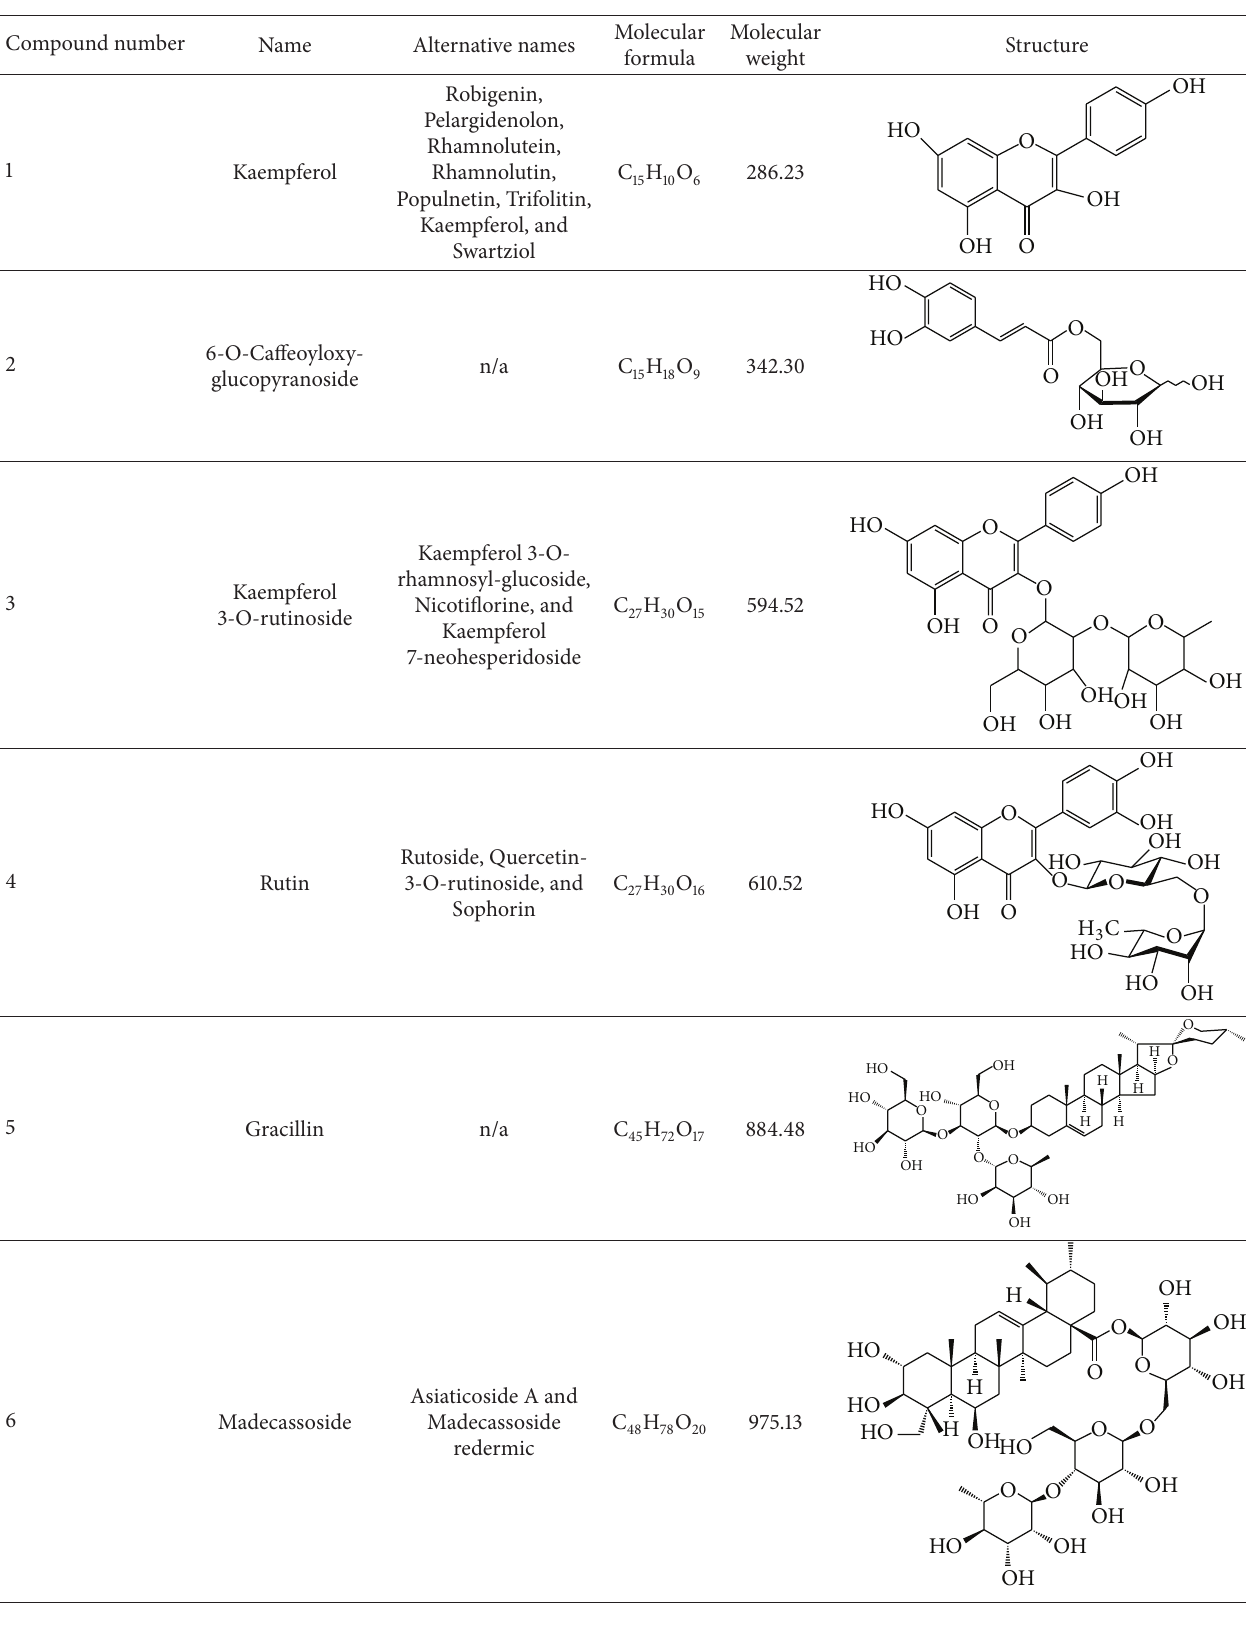
Table 2: Information of Sanjin Tablets